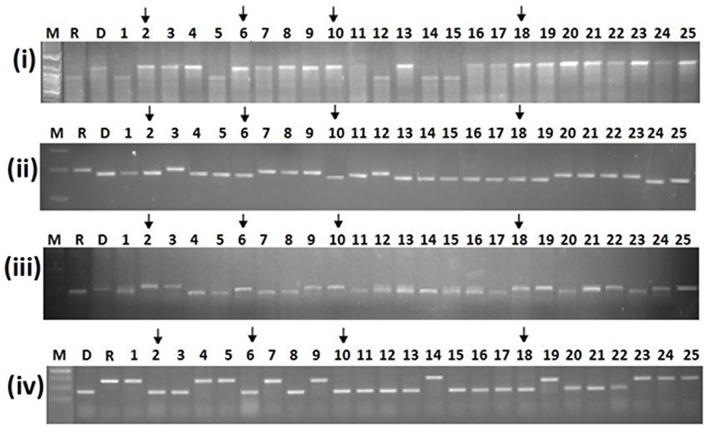
The gene linked markers pTA248, RMWR7.6, AP5659-5, and Pi54MAS were used for screening of Xa21, Xa33, Pi2, and Pi54 genes respectively, in the double intercross F2 plants through PCR. The numbers shown on the top of the each gel represents the double intercross F2 plant numbers. Gel (i), (ii), (iii), and (iv) represents the screening of the double intercross F2 plants derived from the cross IC1F2 X IC2F2. Lanes M: 100 bp molecular weight ladder; R-Recurrent parent (RPHR-1005); D- Donor parent (i & iii- RPBio Patho-1 and ii-FBR1-15 & iv- RPBio Patho-2), 1-25- DICF2 plants; Arrow indicates “tetra homozygous positive plants.”